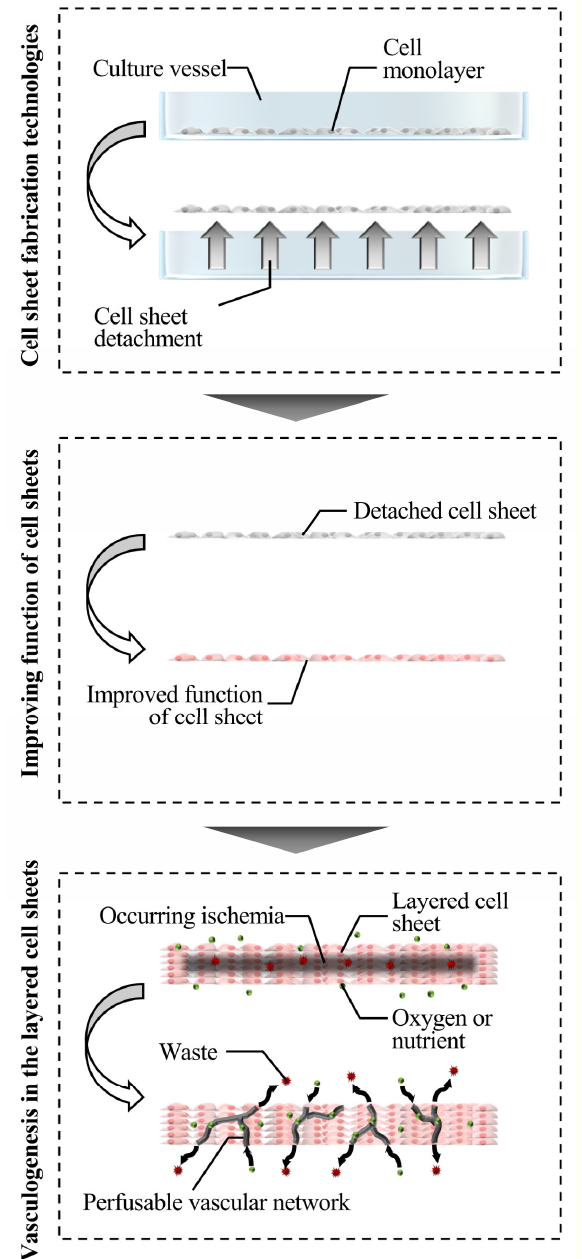
Figure 1. Schematic diagram that categorizes various technologies employed for developing cell sheet technology discussed in this review.